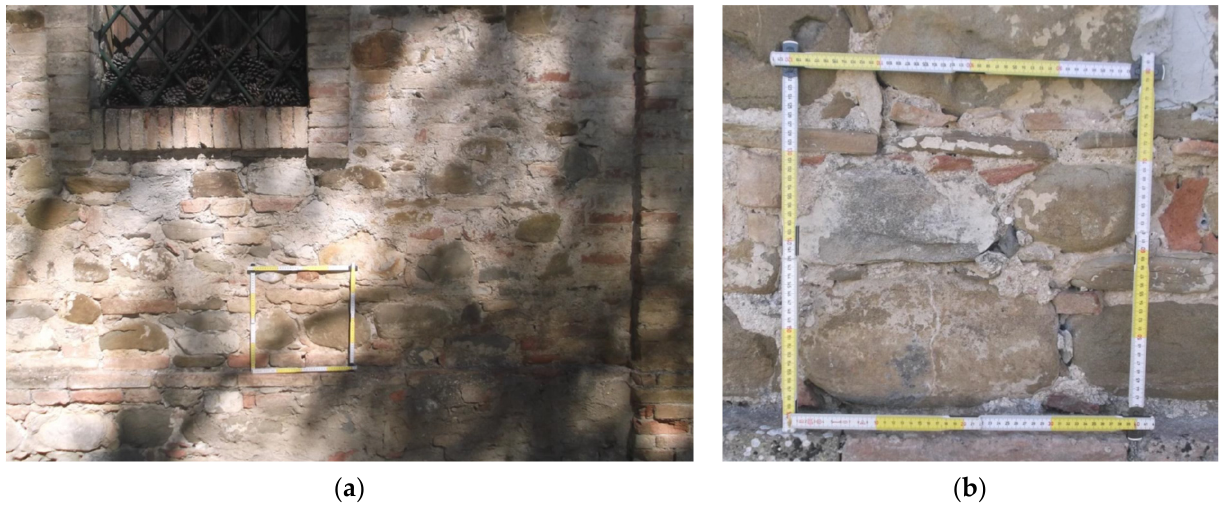
Figure 1. The analyzed building: side elevation and typical plan.